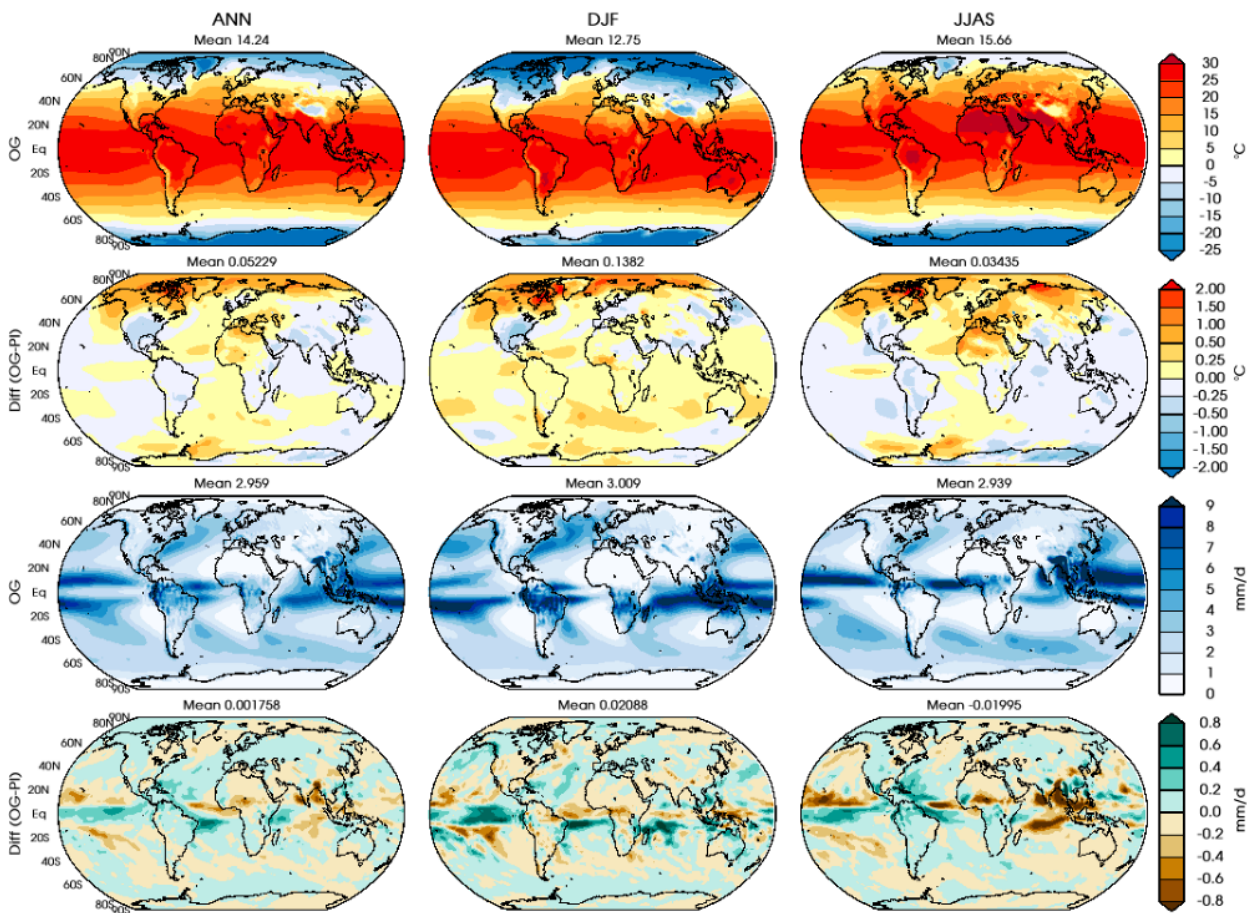
Figure 1. Seasonal mean (annual, DJF, and JJAS) surface air temperature (top row) for the 2.5ka period equilibrium run, differences from the preindustrial period (2.5ka − preindustrial) for all three seasons (second row from top), and seasonal (annual, DJF, and JJAS) mean precipitation (third row from top) and the difference (bottom row) from the preindustrial period (2.5ka − preindustrial). The equilibrium run for the 2.5ka period includes the orbital and GHG concentration changes for the 2.5ka period (referred to as OG; OG = ORB + GHG), the preindustrial period (as PI), and their difference (OG − PI), as simulated by GISS